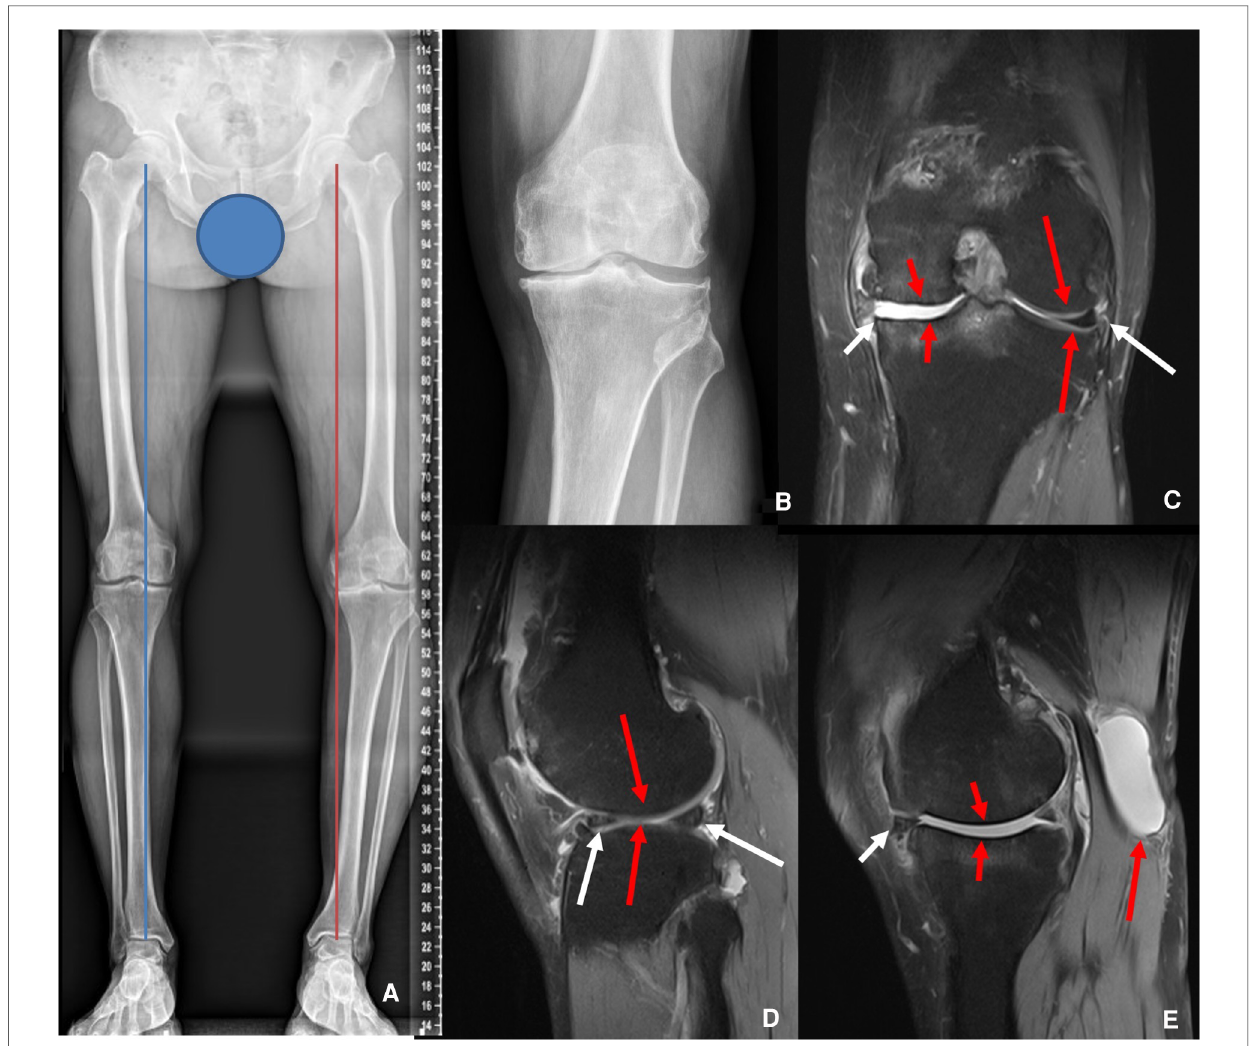
FIGURE 1 Preoperative X-ray and MRI. ( A ) The left Weight-Bearing line (red) was 35 mm more varus than the contralateral side (blue). ( B ) Narrowing of the medial compartment of the left knee. ( C,D ) The short white arrow showed subluxation of the medial meniscus. The short red arrows showed the cartilage wearing on both sides of the medial femur and tibia. The long red arrows showed the normal cartilage on the lateral side of the knee. The long white arrows showed the lateral meniscus was intact. ( E ) The short white arrow showed subluxation of the medial meniscus. The short red arrows showed the cartilage wearing. The long red arrow indicated the popliteal